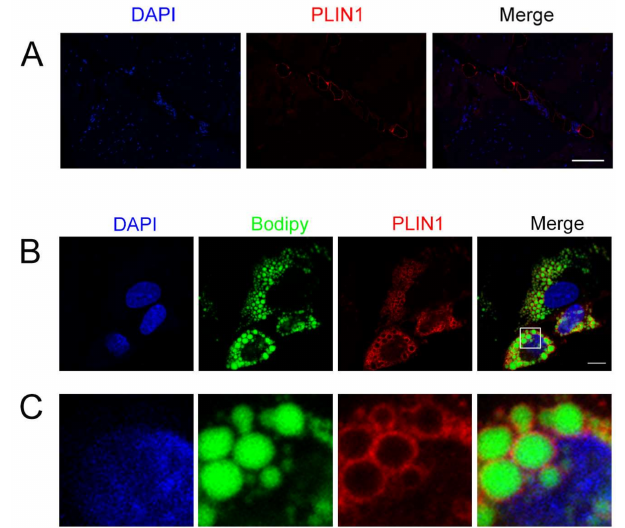
Figure 7. PLIN1 localized in porcine longissimus dorsi muscle and adipocytes. ( A ) Immunohistochemistry of PLIN1 in porcine longissimus dorsi muscle. PLIN1 was stained with antibody PLIN1 (red). Nuclei were stained with 4 (cid:48) ,6-diamidino-2-phenylindole (DAPI, blue). Scale bars: 100 µ m; ( B , C ) PLIN1 immunofluorescence at the surface of lipid droplets (LDs) in porcine adipocytes. PLIN1 was stained with antibody PLIN1 (red). Lipid droplets were stained with Bodipy (green). Nuclei were stained with DAPI (blue). Scale bars: 10 µ m.